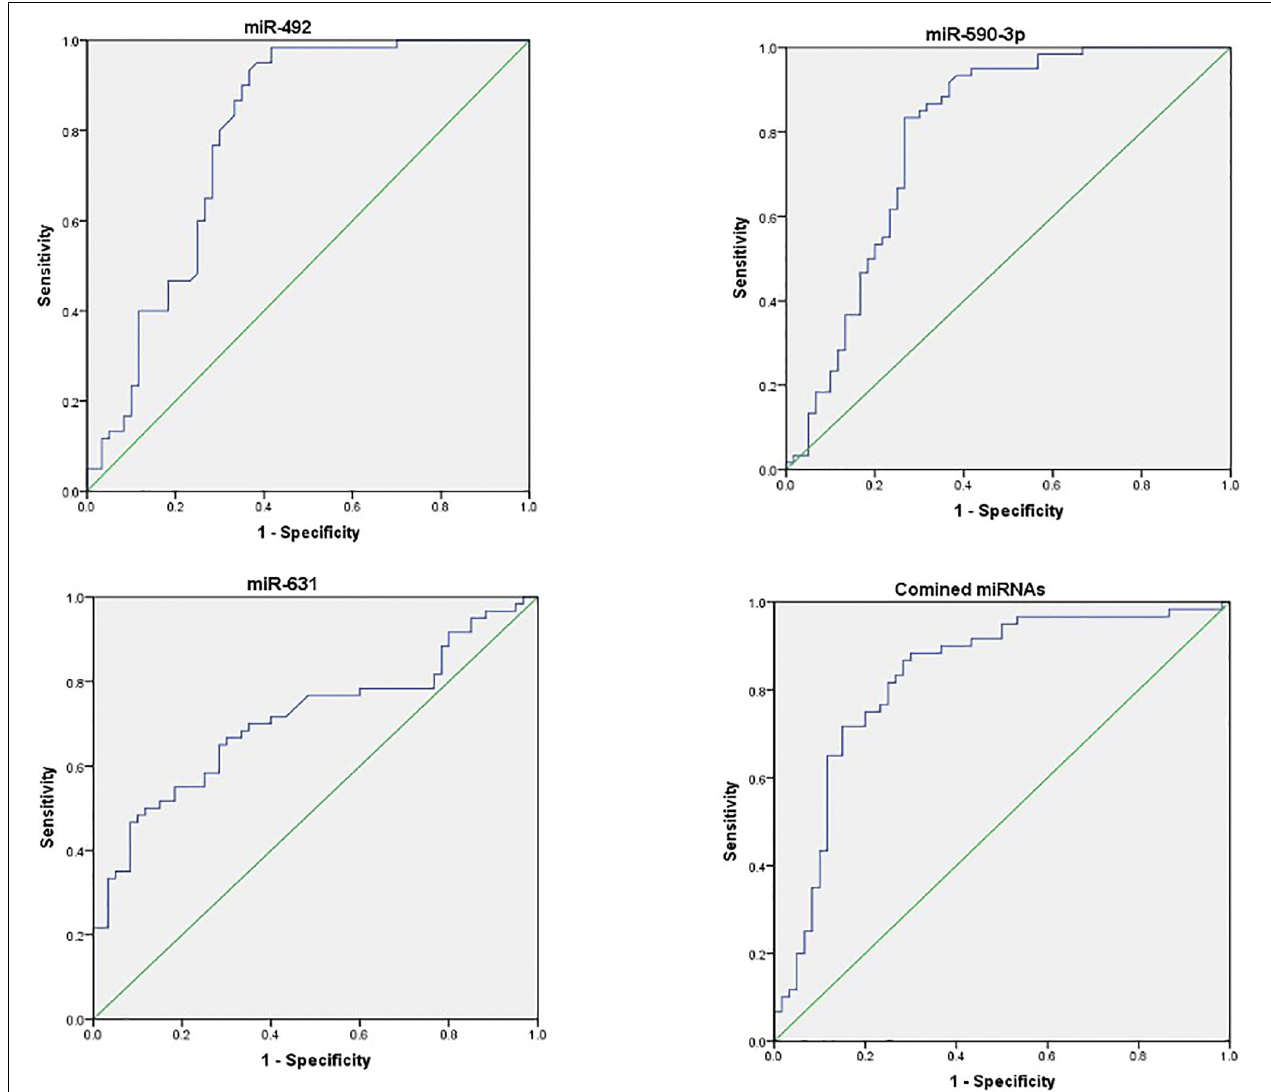
FIGURE 3 | Receiver operating characteristic (ROC) curves of differentially expressed miRNAs between NSCLC patients and healthy controls. ROC curves of miR-492, miR-590-3p, and miR631 showed a moderate distinguishing efficiency. The combination of the three miRNAs showed a slightly higher AUC value.